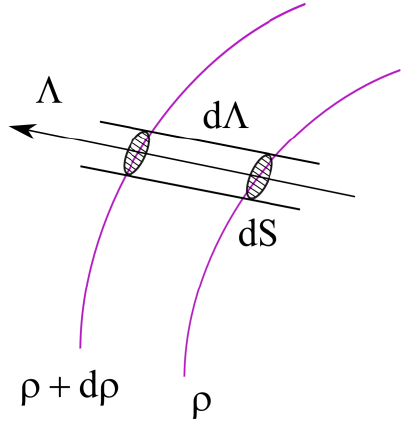
Figure 3. An elementary volume of a narrow infinitesimal beam between the magnetic surfaces la-  beled and d  + .